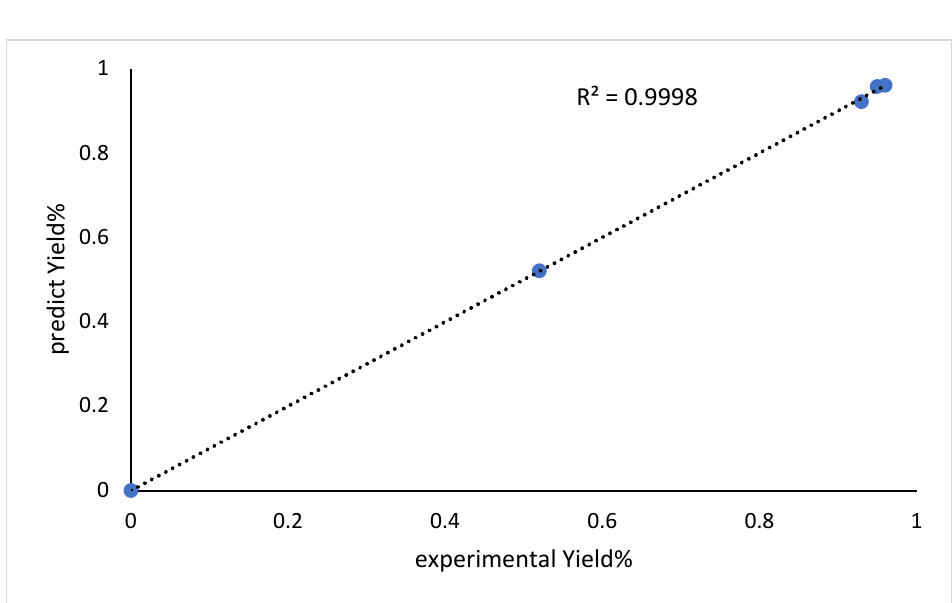
Figure 5. Comparison between the experimental data and kinetic model at a methanol/oil mole ratio of 700:1 and a temperature of 70 °C.